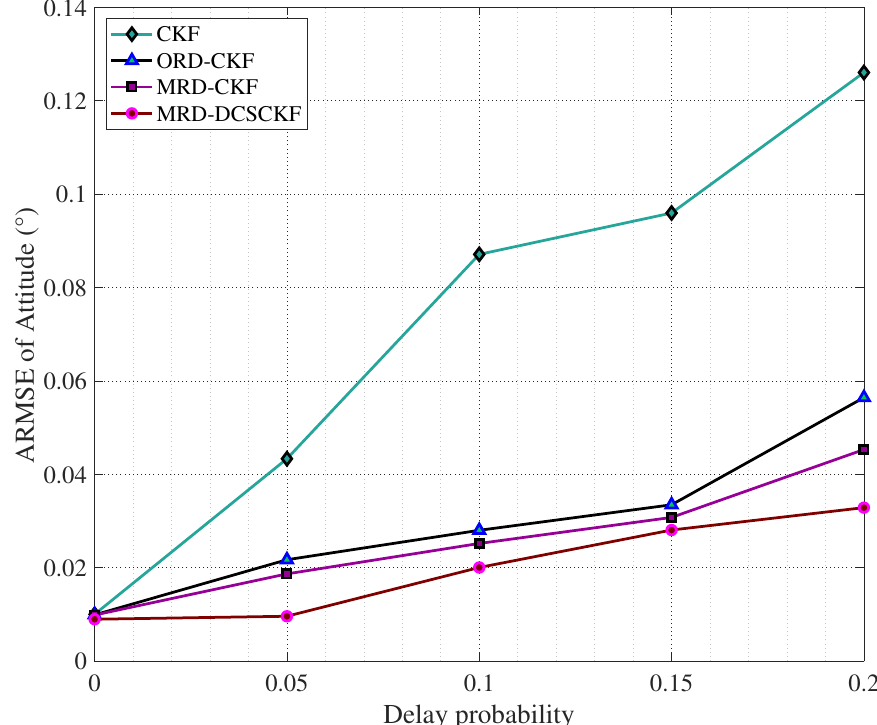
Figure 18. ARMSEs of attitude under different delay probabilities.